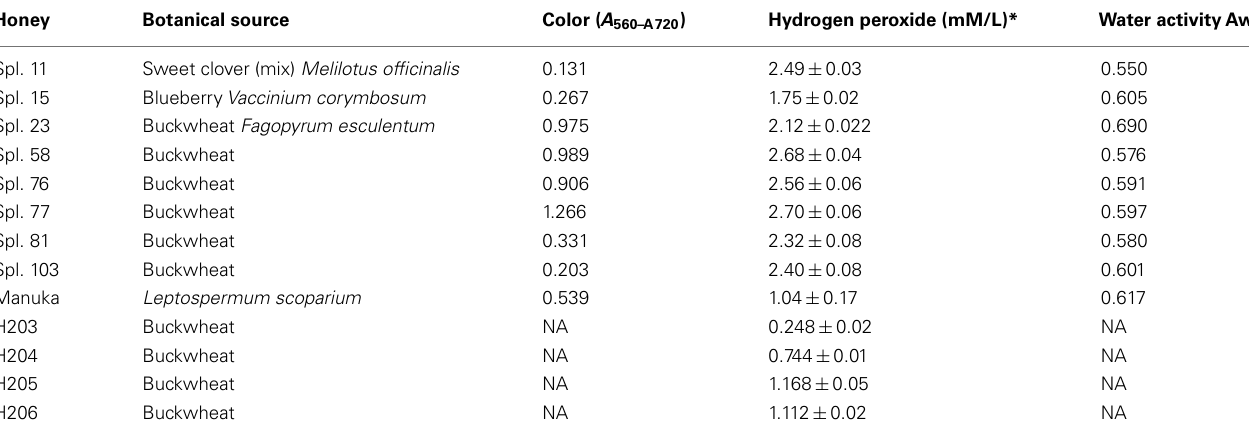
Table 1 | List of honeys.